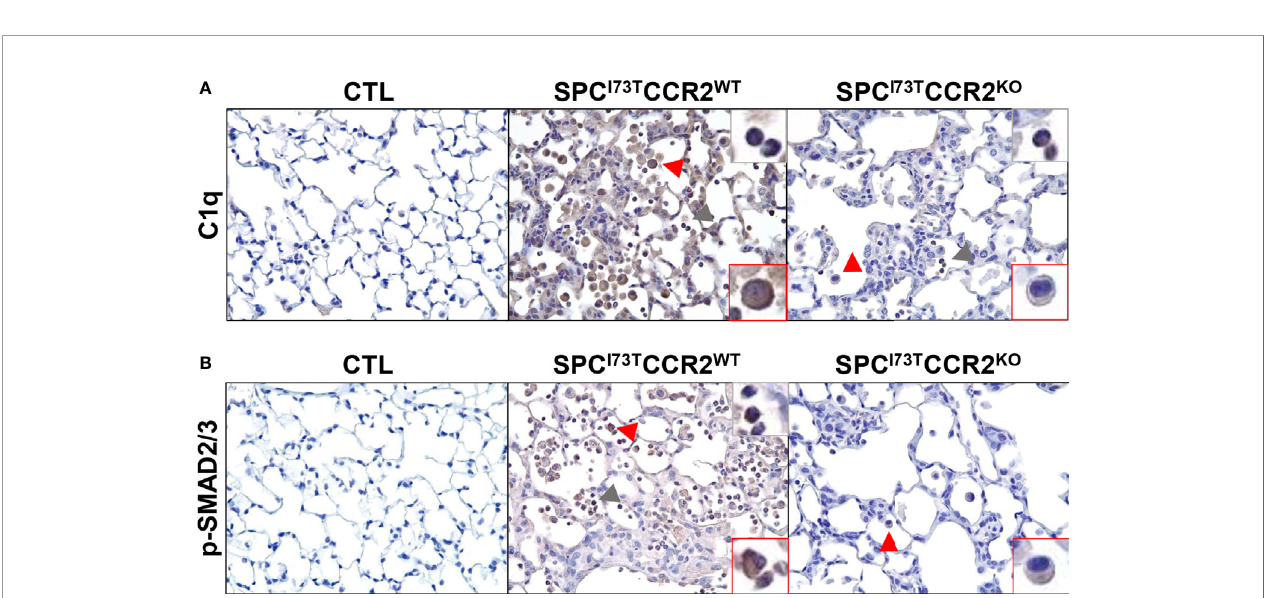
FIGURE 8 | Effects of CCR2 monocyte ablation on in fl ammatory and fi brotic pathways following SP-C I73T induced injury. Histochemical analysis of control (CTL, tamoxifen treated SP-C WT or oil treated SP-C I73T mice), SP-C I73T CCR2 WT and SP-C I73T CCR2 KO lung sections 14 d post injury immunostained with antibody to (A) C1q and (B) p-SMAD2/3. Binding was visualized using a Vectastain kit. Red arrowheads indicate macrophage expression; grey arrowheads indicate non- macrophage expression. Insets show magni fi ed cells; box color matches that of arrowhead. Original magni fi cation, 400x; inset magni fi cation, 750x. Representative sections from 3 mice/group are